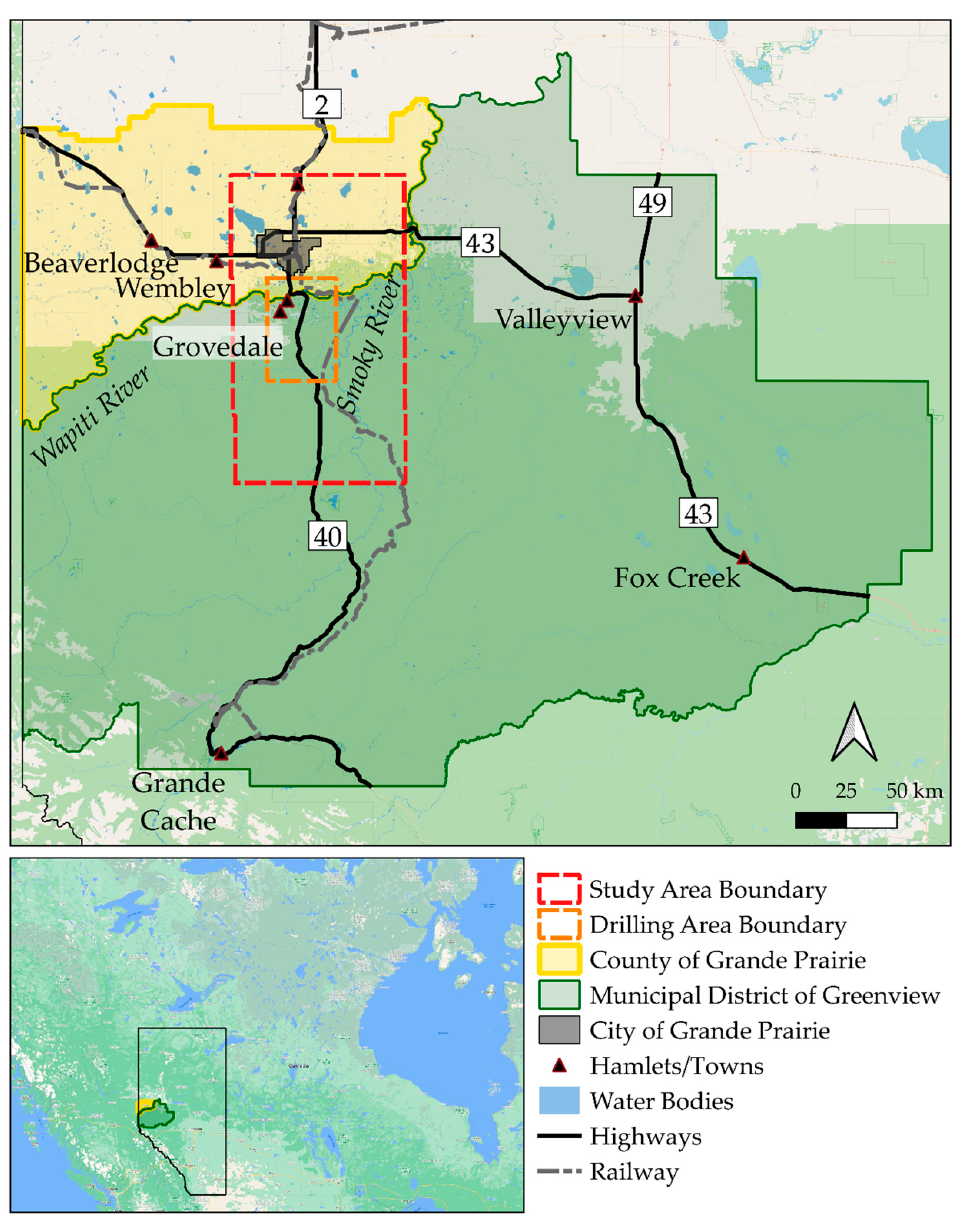
Figure 1. The study area lies within the Municipal District of Greenview (MDGV) and the County of Grande Prairie, and encompasses the City of Grande Prairie.